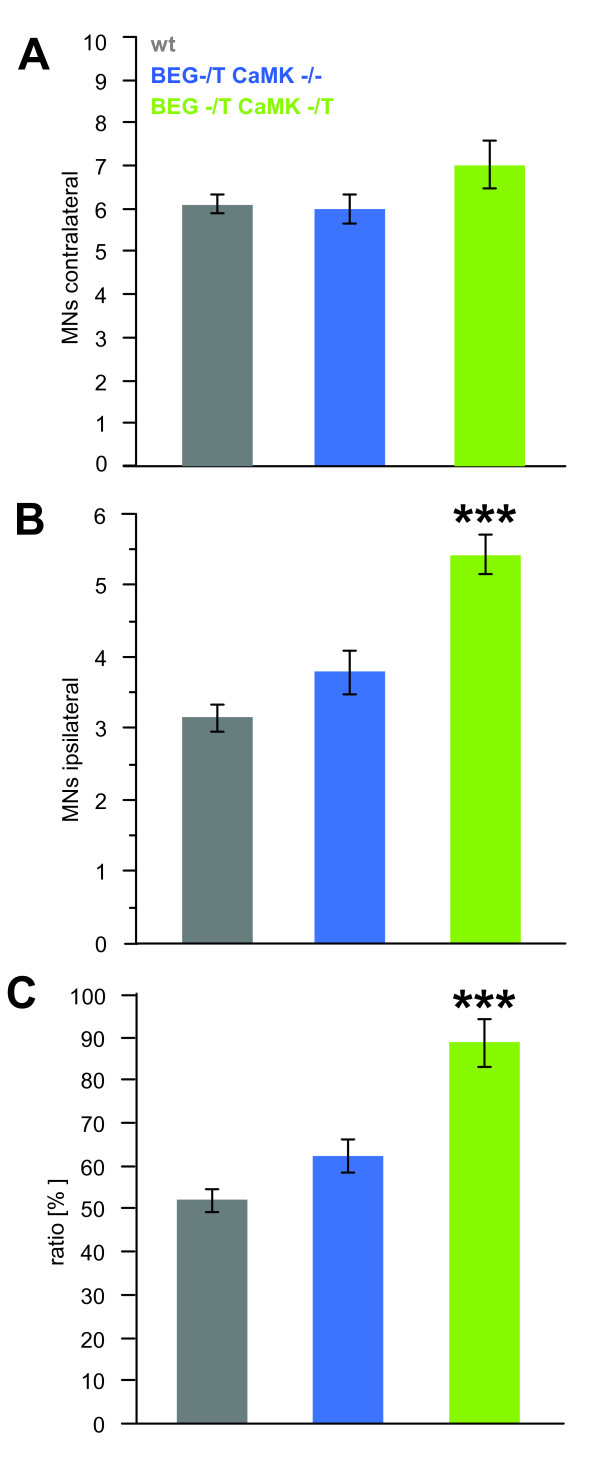
Overexpression of G-CSF improves motoneuron survival following sciatic nerve axotomy in neonatal pups. (A) Quantification of the absolute number of α; motoneurons per section of the lumbar spinal cord on the contralateral (unlesioned) side. Numbers are not significantly different between the three genotypes studied. (B) On the axotomized side numbers of detectable motoneurons are dramatically decreased in the littermate animals lacking the CaMK-tta driver transgene (wt, BEG -/- CaMK-/-; and BEG -/T CaMK-/-), whereas overexpression of G-CSF in the CNS results in significantly higher numbers of surviving motoneurons (***p < 0.0001 by ANOVA and Fisher's LSD post-hoc analysis). (C) Percentage of surviving motoneurons on the ipsilateral (axotomized) relative to the corresponding contralateral (control) side. While only 50 - 60% of the motoneurons survive in the genotypes lacking the CaMK-tta driver transgene, close to 90% of the motoneurons survive in the presence of the driver (i.e. in animals overexpressing G-CSF) (***p < 0.0001 by ANOVA and Fisher's LSD post-hoc analysis). (Number of animals: wt, n = 13; BEG -/T CaMK -/-, n = 6; BEG -/T CaMK -/T, n = 7; 6 sections were studied per animal).